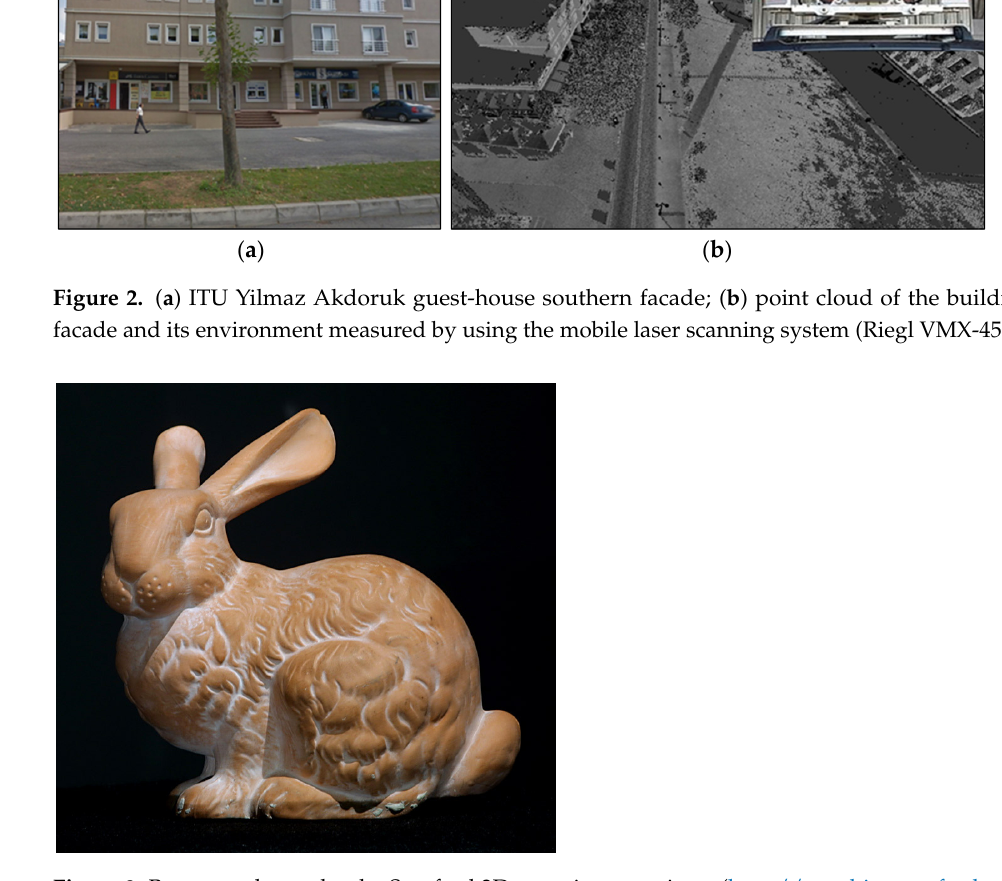
Figure 3. Bunny sculpture by the Stanford 3D scanning repository (http://graphics.stanford.edu/data/3Dscanrep/, accessed on 15 March 2021).